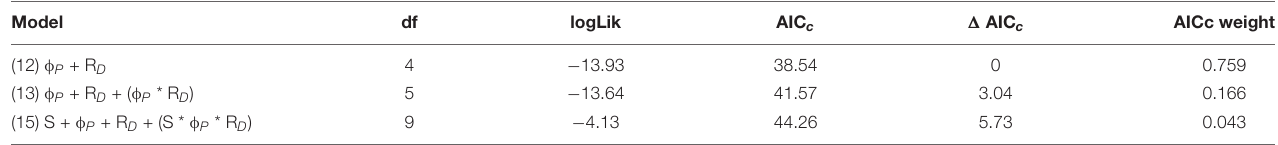
TABLE 3 | AICc table results of top model set selected in the evaluation of the role of invariability of dominants, mean species richness, population invariability and population asynchrony on overall community invariability in an intertidal community exposed to a press disturbance.